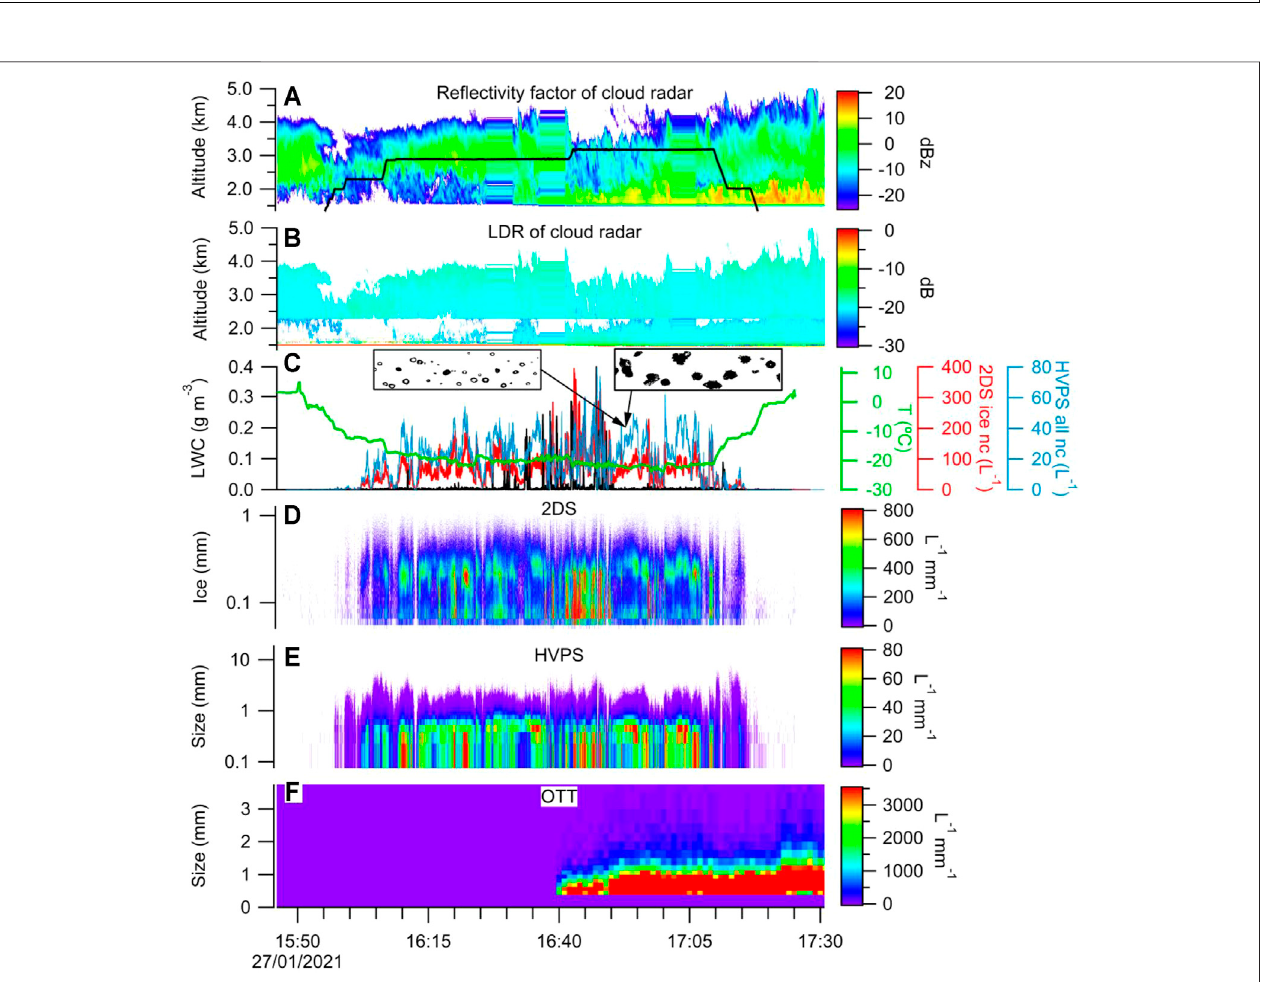
FIGURE7|(A) Re fl ectivityfactor(dBZ)(theblacklineisaircraftaltitude), (B) LDR(dB)observedbyKacloudradar, (C) LWC(gm − 3 )(blackline)andTemperature( ° C) (green line) byFCDP, Ice number concentration(L − 1 ) (red lines)by 2DS, all particle number concentration (L − 1 ) (blue lines) byHVPS, 2DS images (Bar graph above c) (D) Ice size distribution (L − 1 mm − 1 ) by 2DS, (E) Particle size distribution (L − 1 mm − 1 ) by HVPS, (F) Particle size distribution (L − 1 mm − 1 ) by OTT from 1630 BJT to 1705 BJT Jan 27, 2021.